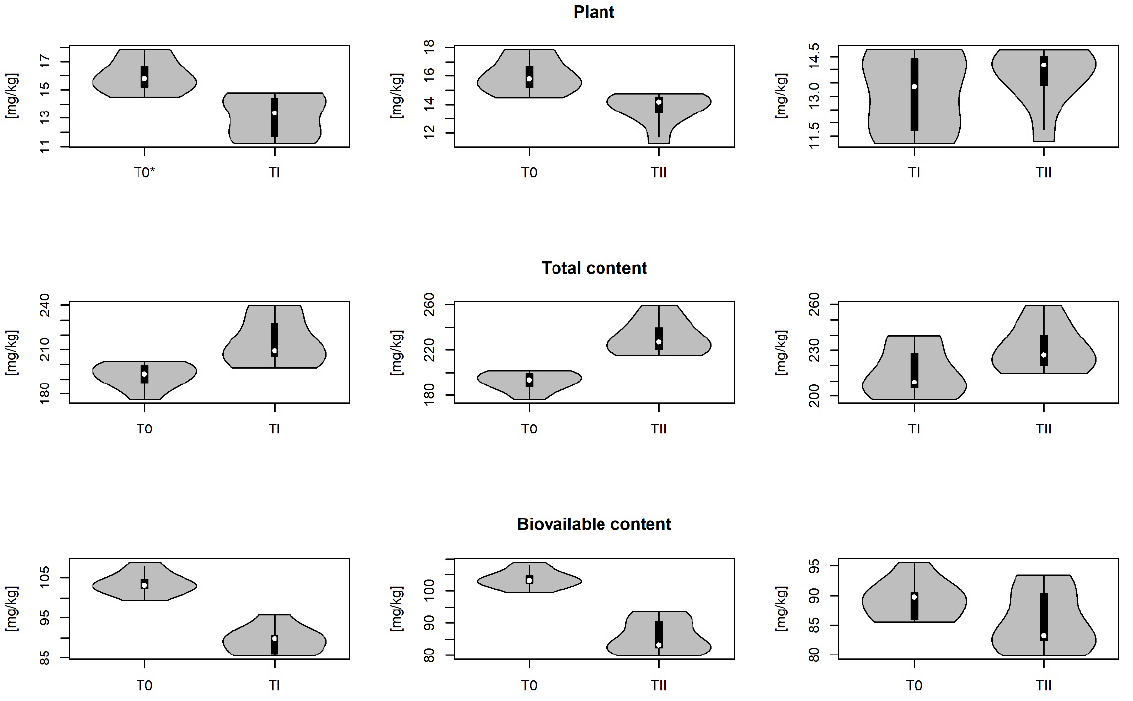
Figure 6. Cu contents in oat and soil (total and bioavailable amounts). * for descriptions see Material and Methods. Statistically significant differences and p -value are presented in Table 3.